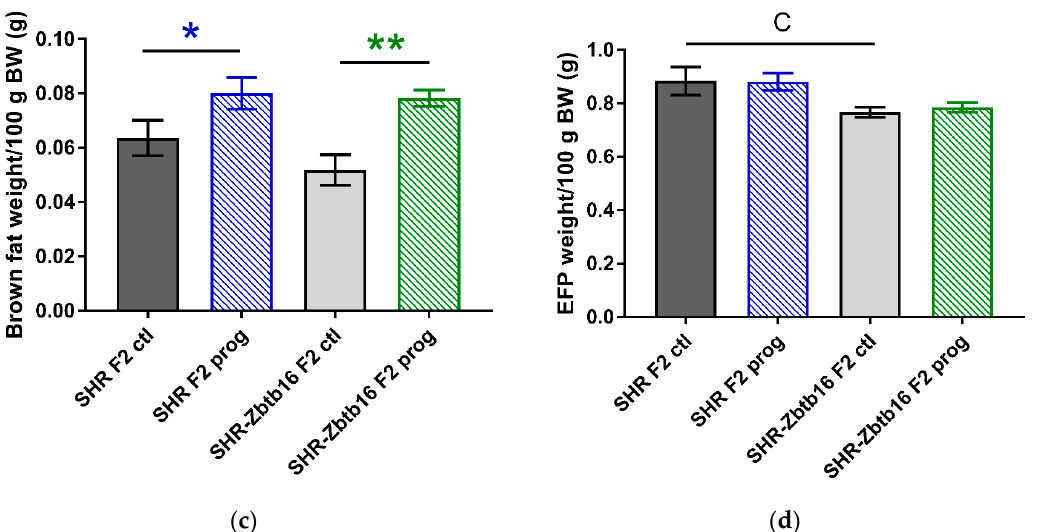
Figure 6. Morphometric assessment. Retroperitoneal fat pad weight ( a ), liver weight ( b ), interscapular brown fat weight ( c ), epidydimal fat pad weight ( d ) per 100 g of body weight in adult SHR F2 control male offspring (dark grey bars), SHR-Zbtb16 F2 control male offspring (light grey bars), F2-programmed SHR male offspring (blue patterned bars), F2-programmed SHR-Zbtb16 male offspring (green patterned bars) in 6 months of age. The strain comparison using the post-hoc Fisher’s least significant difference test of the two-way ANOVA for STRAIN and PROGRAM as major factors are indicated as follows: * p < 0.05, ** p < 0.01. Effect of programming in SHR and SHR-Zbtb16 strains is represented by blue and green asterisks (*), respectively. C represents STRAIN differences between F2 SHR and SHR-Zbtb16 control males, RPFP/100g BW CC p < 0.01, higher in SHR F2 control males; EFP/100 g BW C p < 0.05, higher in SHR F2 control males. F represents STRAIN differences between F2-programmed SHR and SHR-Zbtb16 males, RPFP/100 g BW *, higher in SHR F2-programmed males.